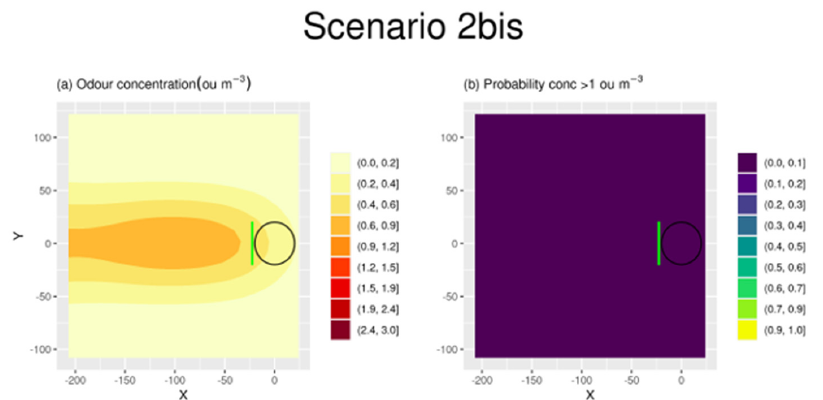
Figure 12. Odour concentrations ( a ) and exceedance probability of the 1 ou m − 3 threshold ( b ) at a 1.7 m height as simulated by SCICHEM. Meteorology and total emissions are the same as in the wind gust episode of scenario 2, but with the emission field replaced by a 40 m − diameter circular source, represented in black in the graphs. Coordinates x and y are expressed as distances in meters from the center of the source. The barrier is represented as a green rectangle.